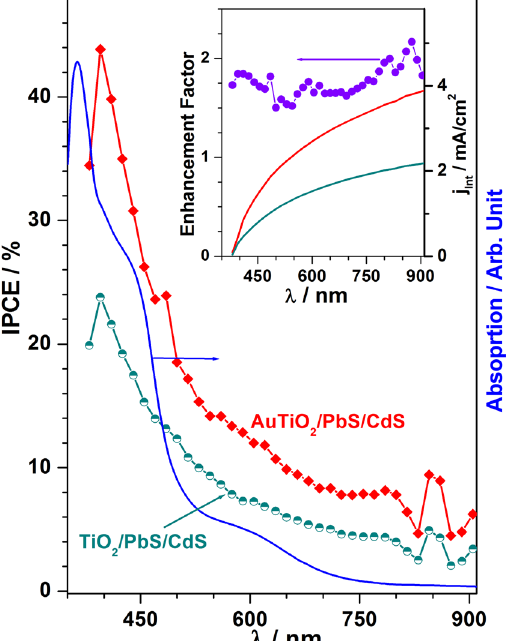
Figure 5. Wavelength dependent IPCE performance of the AuTiO 2 /PbS/CdS and TiO 2 /PbS/CdS photoanodes. Optical absorption of AuTiO 2 /PbS/CdS photoanode is also plotted for correlation between IPCE and light absorption. Inset shows the IPCE enhancement of AuTiO 2 /PbS/CdS over TiO 2 /PbS/CdS. An enhancement factor of 1.7–2 was observed over the entire absorption regime reiterates the active PIRET role in improving the current and HER. Integrated current obtained from IPCE for both photoanodes are also